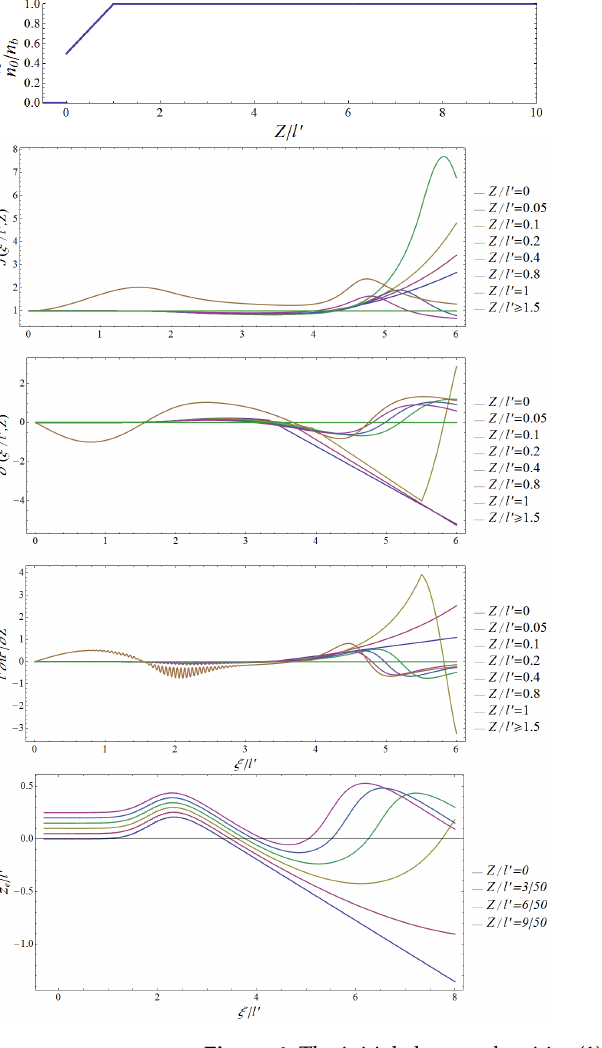
Figure 6. The initial electron densities (1), (2) of Figure 2 (first line; respectively left, right), and below, the corresponding plots of J , σ , l (cid:48) ∂ u z / ∂ z vs. ξ during interaction with the pulse in Figure 1 for a few sample values of Z . As can be seen, the right J remains positive for ξ < l and all Z , while the left J becomes negative for very small Z and ξ (cid:46) l ; correspondingly, the right worldlines do not intersect, while the right ones do (see the down z e